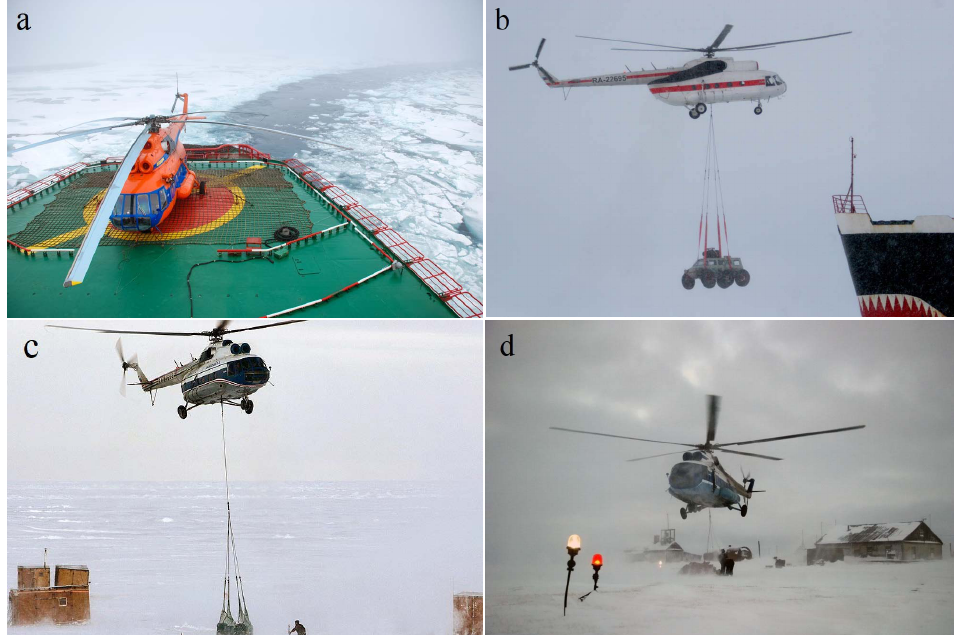
Figure 2. Use of a helicopter to unload a vessel: ( a ) is a helicopter on a cargo ship; ( b ) is the unloading from a vessel using a helicopter; ( c ) is the delivery from a payload ship for polar explorers; ( d ) is the delivery from a payload ship for residential and shift camps (Data in the free database https://unsplash.com, accessed on 2 February